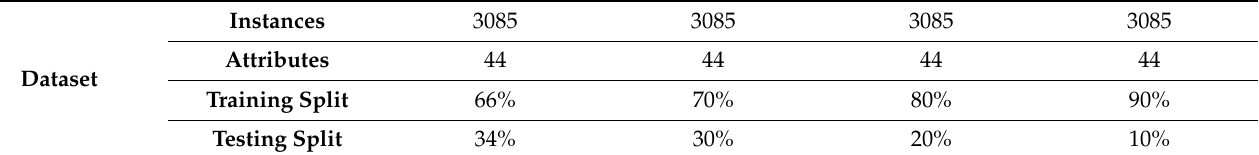
Table 2. Run information (single feature selection technique).